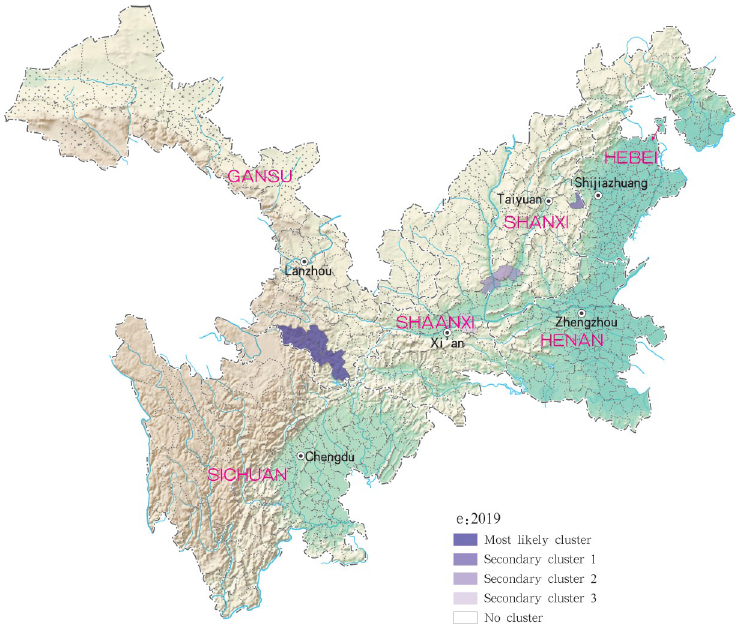
Fig 20. Spatial clustering analysis of mountain-type zoonotic visceral leishmaniasis incidence in 6 provinces, China in